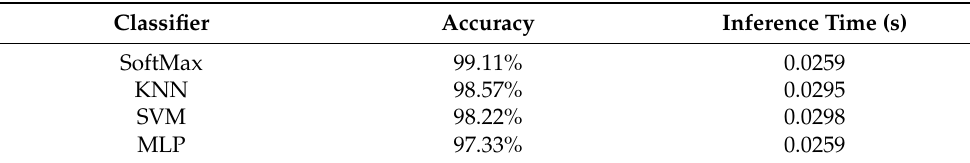
Table 5. Recent studies and their implemented models showing data size and cattle identification accuracy.